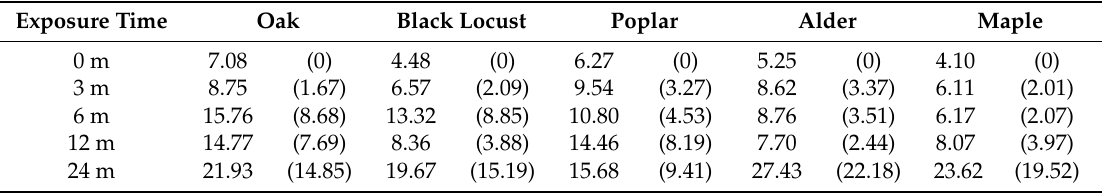
Table 8. Exposure time-dependence of arithmetical mean profile deviation R a (roughness differences ∆ R a are in